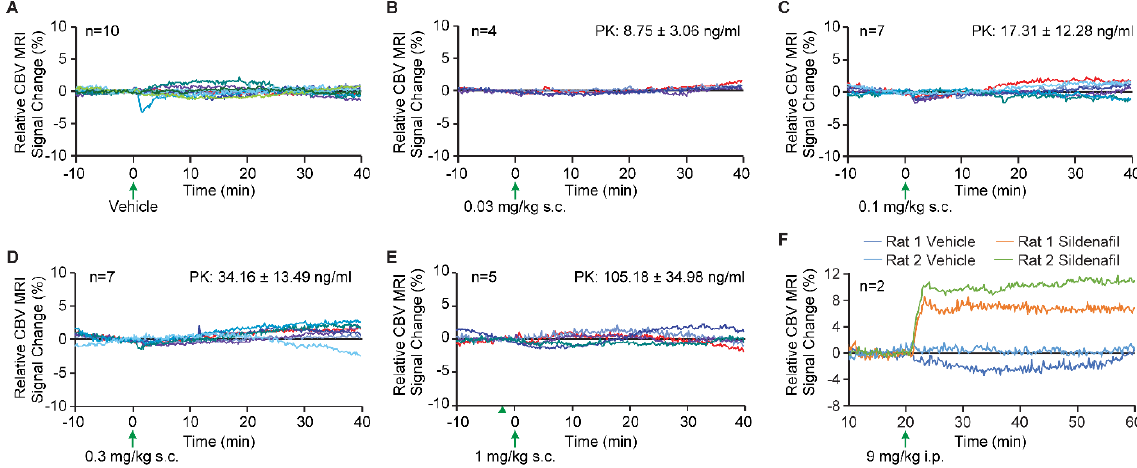
Figure 4. The effect of vericiguat for cerebral blood volume. No changes in cerebral blood volume were detected for any dose of vericiguat compared to vehicle injection. Plasma PK results for each dose group indicate successful delivery of vericiguat in a dose-dependent fashion. ( A ) Vehicle-only administration, ( B ) 0.03 mg/kg, ( C ) 0.1 mg/kg, ( D ) 0.3 mg/kg, ( E ) 1 mg/kg, and ( F ) 9 mg/kg sildenafil. Only the first 10 min of baseline and 40 min post-vehicle or vericiguat/sildenafil are shown for brevity, and each line for the vehicle and vericiguat plots ( A – E ) represents one animal. In ( F ), the vehicle and sildenafil data are from same